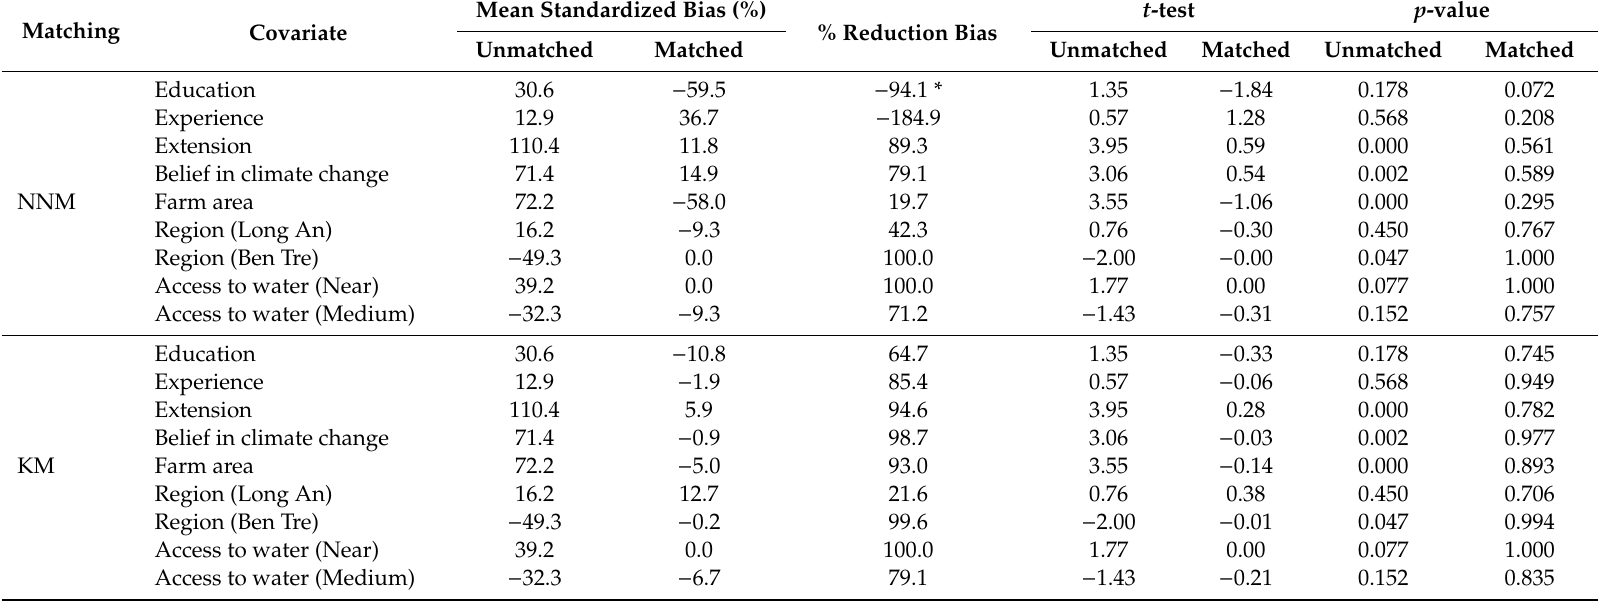
Table 12. Result of balance test of treatment variable of CSA